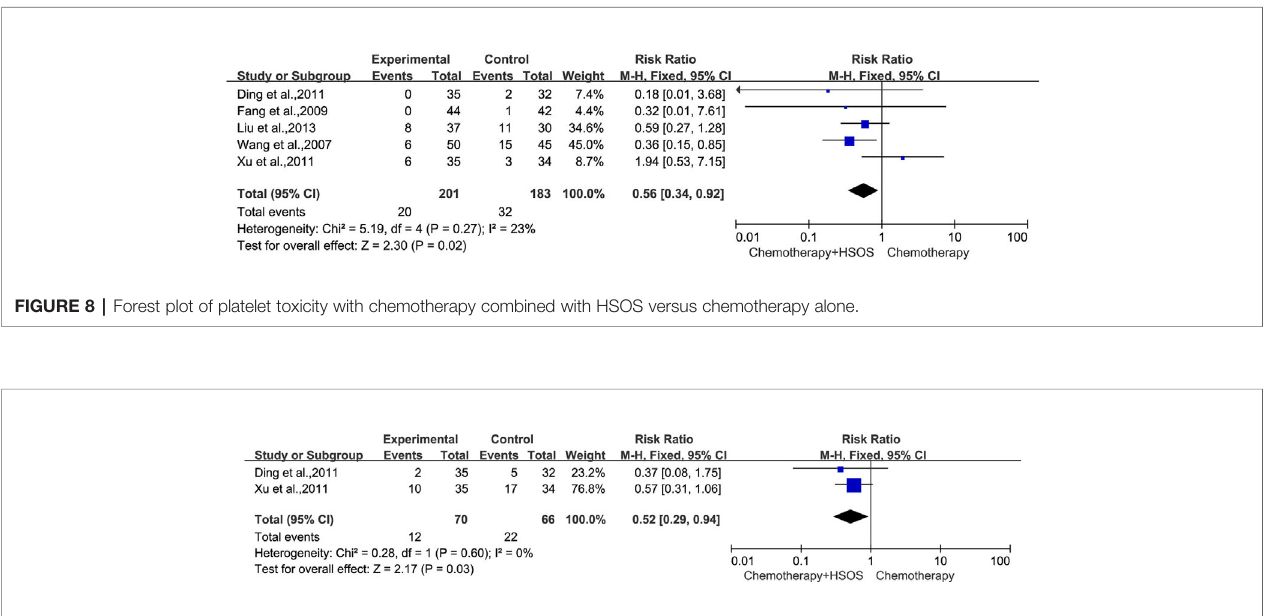
FIGURE 9 | Forest plot of vomiting toxicity with chemotherapy combined with HSOS versus chemotherapy